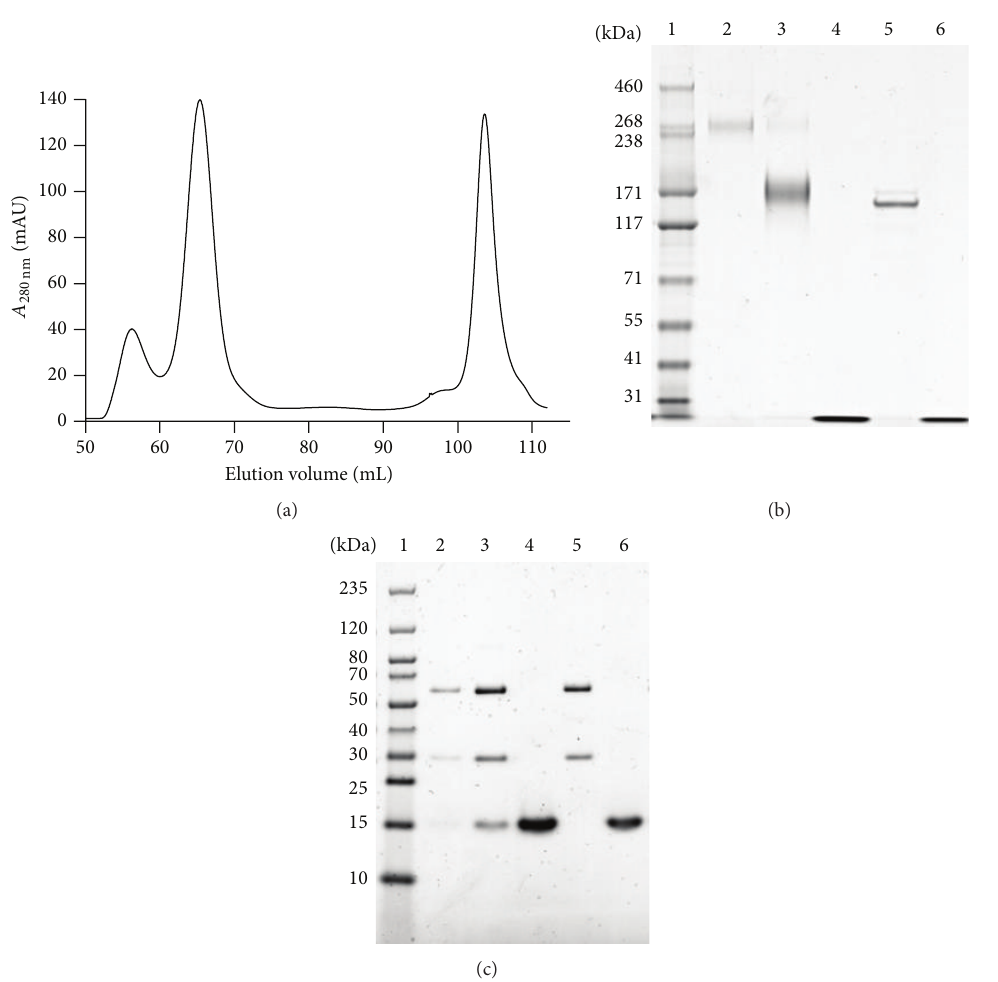
Figure 3: Purification of monomeric SPDP-based ADCs. (a) Size exclusion chromatography of the SPDP-based immunoconjugate preparation on a HiLoad 16/60 Superdex 200 pg column. Eluted column fractions were analyzed by SDS-PAGE under nonreducing (b) and reducing (c) conditions. Lane 1: molecular weight marker; lanes 2–4: column fractions eluting at 58.6 mL, 67.9 mL, and 106.4 mL, respectively; lane 5: huRFB4 IgG (1 𝜇 g); and lane 6: ONC (1 𝜇 g).